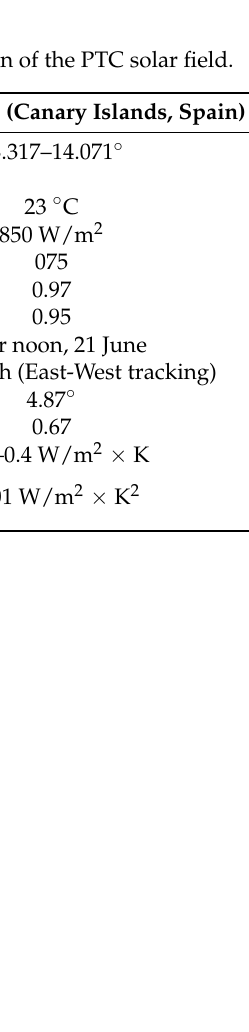
Table 3. Location and design conditions for the efficiency computation of the PTC solar field.